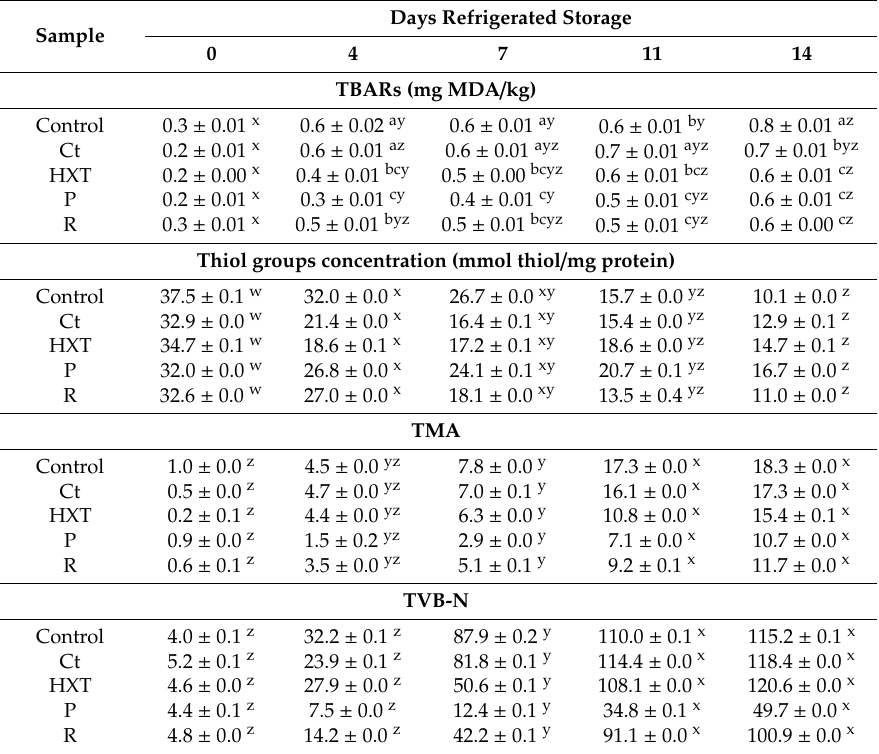
Table 4. Physical-chemical quality expressed by changes produced on lipid oxidation (thiobarbituric acid reactive substances (TBARs)) (m ± s.e. mg MDA / kg), protein oxidation (thiol groups concentration) (m ± s.e. mM thiol group / mg protein) and fish degradation (trimethylamine (TMA) and total volatile